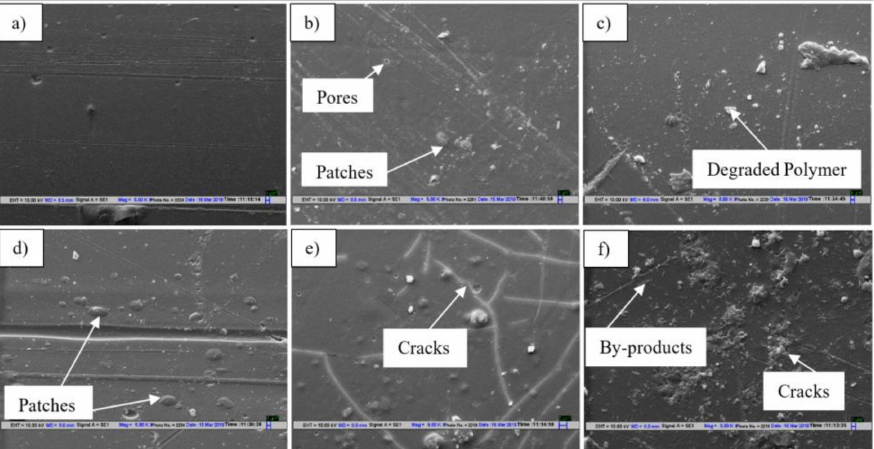
Figure 9. SEM micrographs of PLA UV-treated scaffolds at different time intervals: ( a ) 0 min, ( b ) 1 min, ( c ) 2 min, ( d ) 5 min, ( e ) 10 min, and ( f ) 15